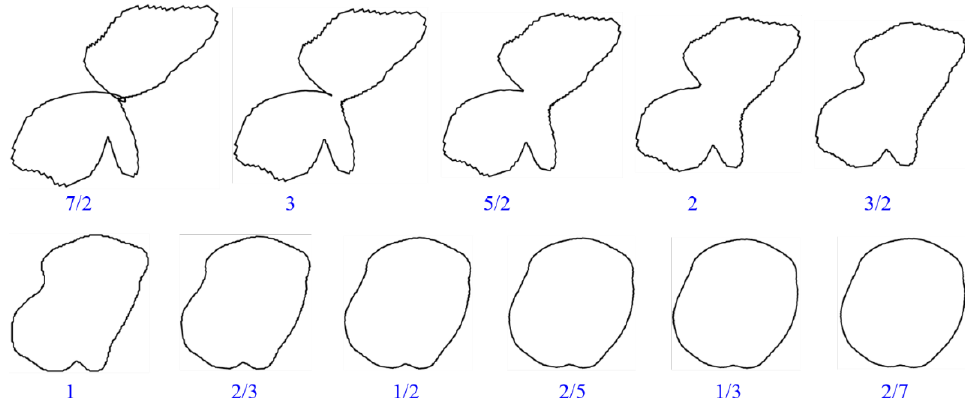
Figure 9. The results of grain roundness change.